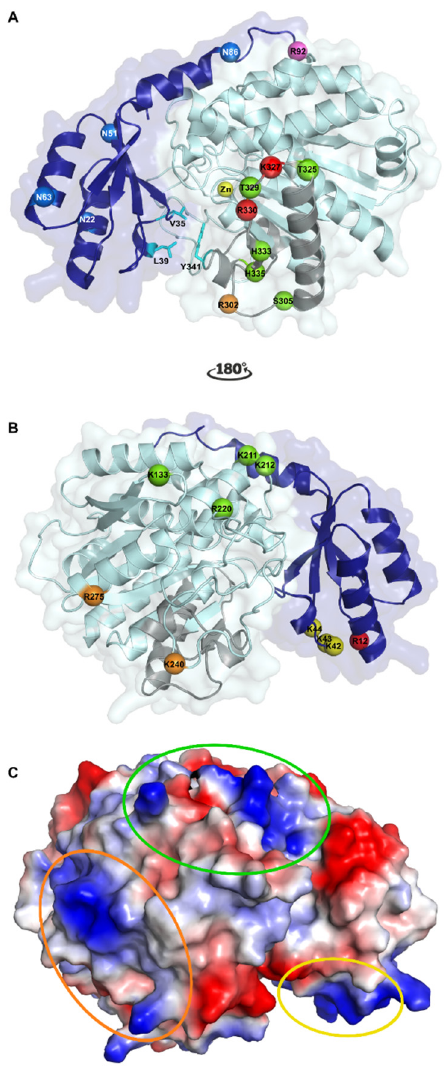
Figure 1. Crystallographic structure of human thrombin activatable fibrinolysis inhibitor (TAFI). ( A ) Cartoon representation of TAFI. The activation peptide (AP) and the catalytic moiety are colored in dark and light blue, respectively. The catalytic zinc-ion in the active center is shown as a yellow sphere. The four glycosylation sites in the AP (Asn22, Asn51, Asn63, and Asn86) are represented by blue spheres. TAFI can be activated through cleavage at Arg92 (shown as a magenta sphere) by thrombin, plasmin, or the thrombin/thrombomodulin complex. Upon the subsequent conformational change to inactivated TAFIa, (TAFIai) a cryptic cleavage site at Arg302 (shown as an orange sphere) becomes exposed and can be cleaved by plasmin or thrombin. Two additional plasmin